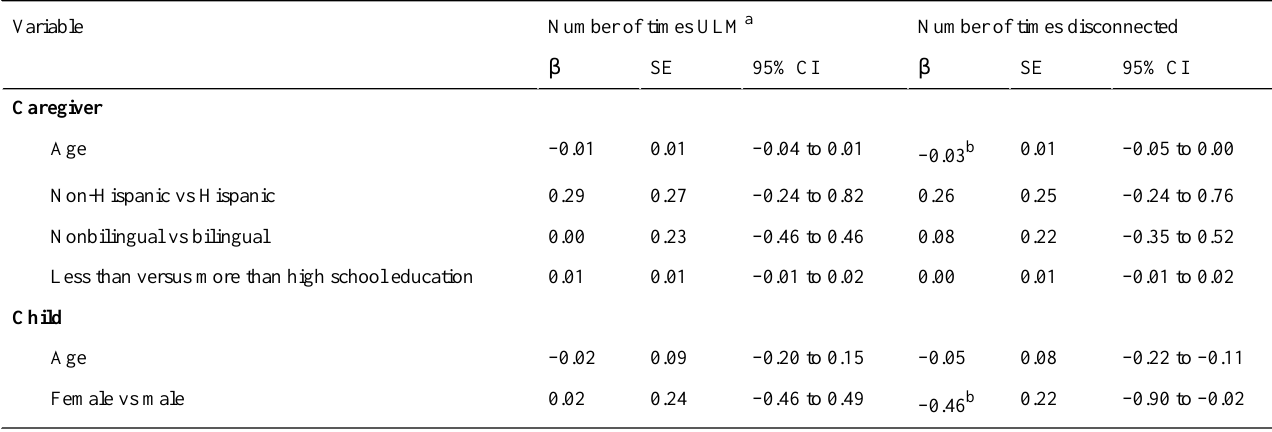
Table 5. Linear regressions for relations between teen demographics and objective measures of reliability of mobile phone service. The first group of predictors listed served as the comparison group for the binary logistic regression analyses and were coded as 0, while the second group was coded as